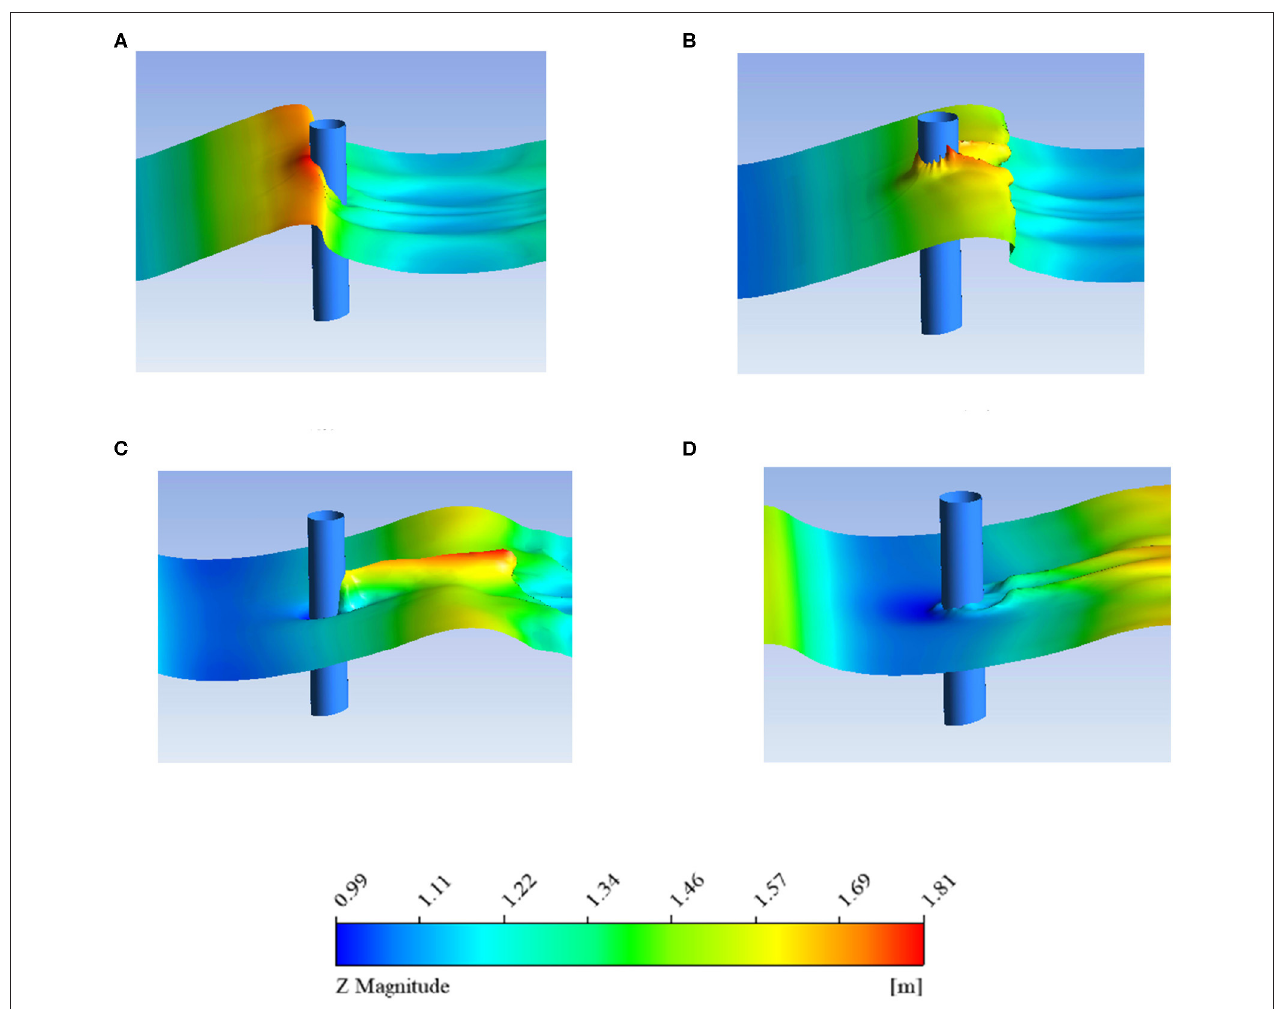
FIGURE 13 | Breaking wave ( ξ 0 = 0.438) flow around the monopile foundation. (A) time = 9s; (B) time = 9.48s; (C) time = 9.8s; (D) time = 10.12s. (2) Pressure acting on the foundation obtains its largest